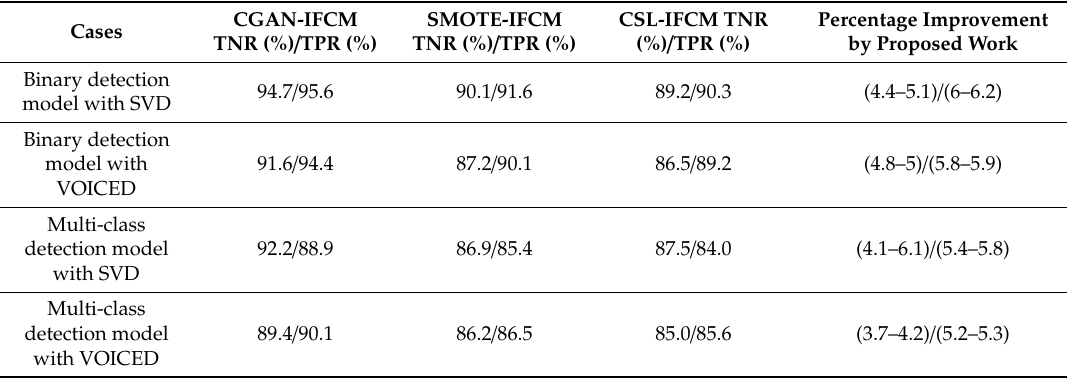
Table 8. Performance comparison between CGAN-IFCM, synthetic minority oversampling technique (SMOTE)-IFCM, and cost-sensitive learning (CSL)-IFCM.